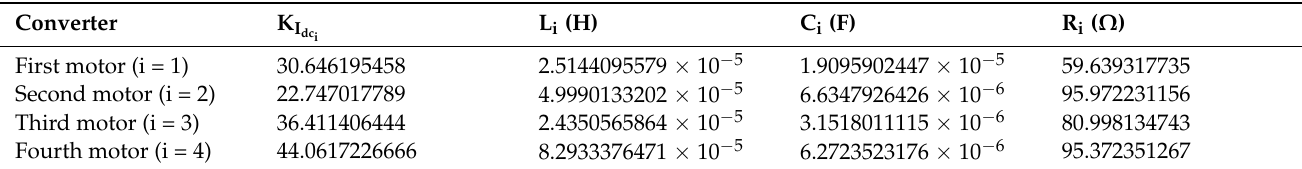
Table 8. The values of optimized parameters of the I controllers and DC/DC converters by